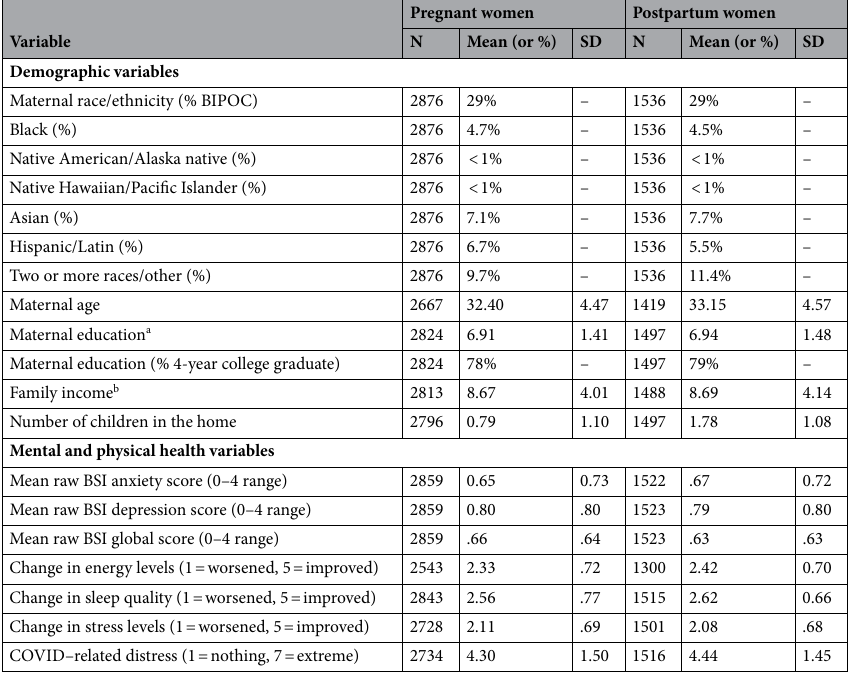
Table 1. Descriptive statistics. a Education was coded as 1 = < 10th grade, 2 = 10–12th grade, 3 = high school/ GED, 4 = apprenticeship/trade school, 5 = partial college, 6 = 2-year college, 7 = 4-year college, 8 = graduate degree. b Income was coded as 1 = < 10 k, 2 = 10–20 k, 3 = 20–30 k, 4 = 30–40 k, 5 = 40–50 k, 6 = 50–60